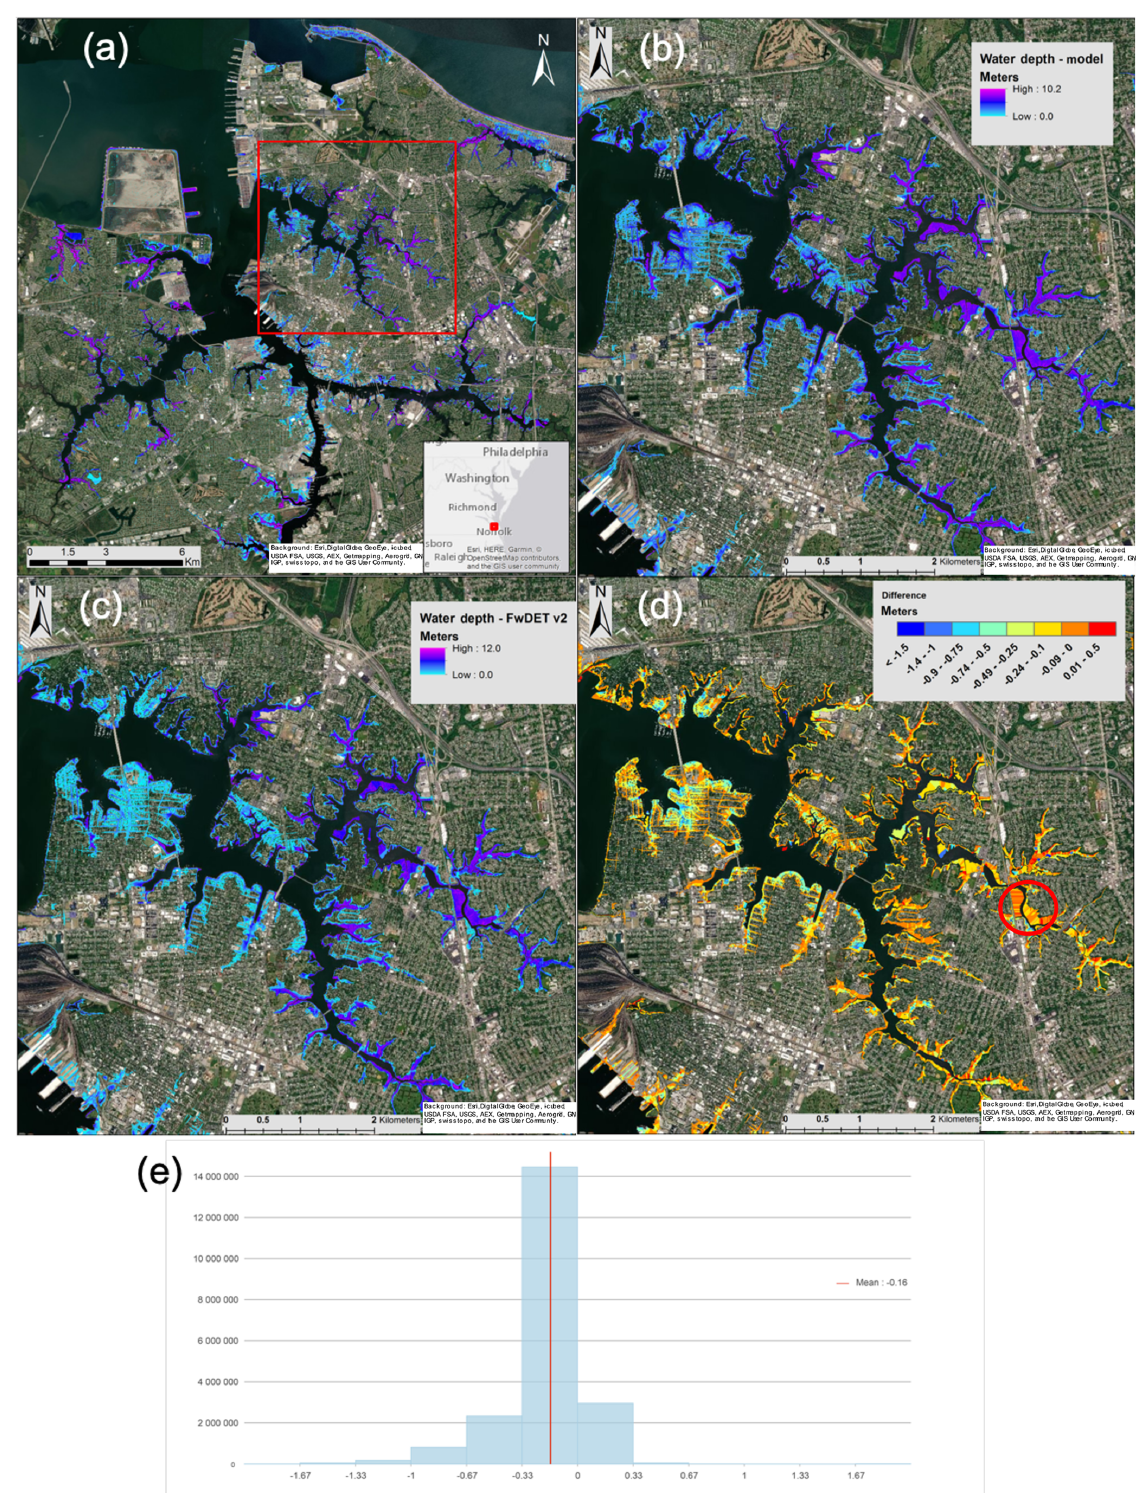
Figure 2. The Norfolk–Portsmouth August 2011 Hurricane Irene flooding case study: (a) simulation domain, location overview map (bottom right inset), and the zoom-in extent used in panels (b) – (d) over the Lafayette River tidal estuary (red box); (b) model-simulated maximum water depth map; (c) FwDET v2.0 floodwater map; (d) difference map between panels (b) and (c) [FwDET v2.0 − model]; (e) histogram of grid cells in the difference map (d) . Background sources: Esri, DigitalGlobe, GeoEye, i-cubed, USDA FSA, USGS, AEX, Getmapping, Aerogrid, IGN, IGP, swisstopo, and the GIS user